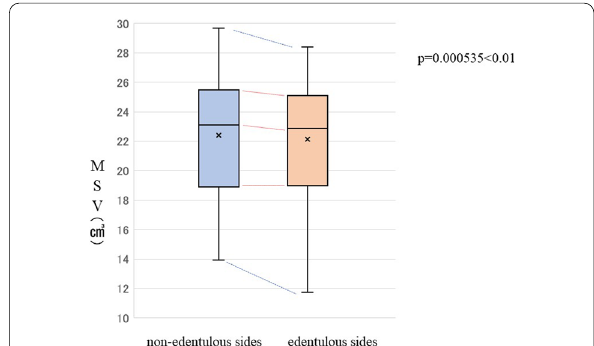
Fig. 4 Comparisons of MSV based on missing teeth. MSV maxillary sinus